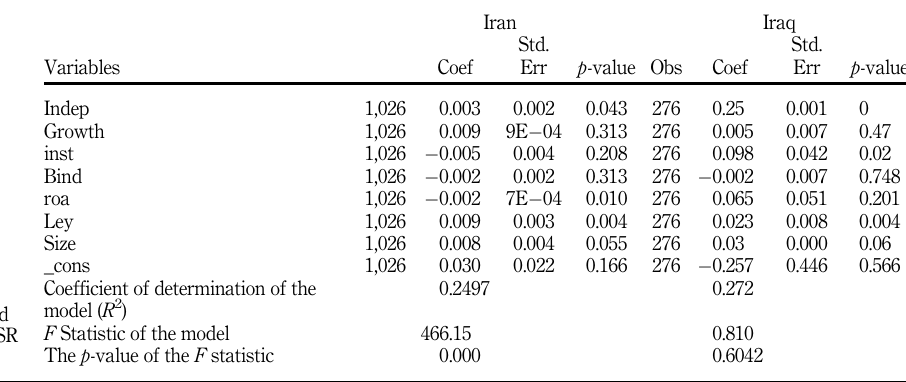
Table 7. The results of board independence on CSR (Model